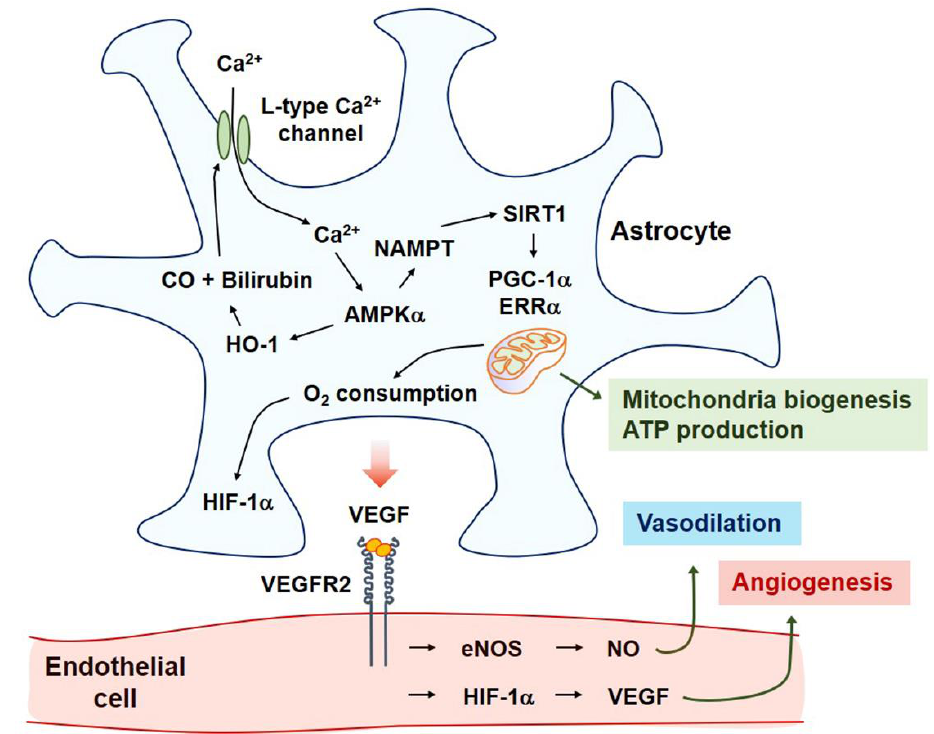
Figure 2. After the ischemia-reperfusion injury, HO-1 is expressed in the astrocytes of the penumbra of the ischemic brain. CO and bilirubin can be produced via enzymatic activity of HO-1, which then activates the L-type Ca 2+ channel, leading to the entry of extracellular Ca 2+ . Ca 2+ -mediated AMPK α - HO-1 circuit results in NAMPT gene expression and consequent SIRT1 activation. Deacetylation of PGC-1 α by SIRT1 activates ERR α expression. PGC-1 α -ERR α axis induces mitochondrial biogenesis, ATP production, and increased O 2 consumption. Reduction of O 2 inhibits PHD2 activity and then stabilizes HIF-1 α protein. Both the PGC-1 α -ERR α pathway and HIF-1 α pathway induce the expression and secretion of VEGF. VEGF dimerization and binding to VEGFR2 triggers the eNOS – NO axis and HIF-1 α– VEGF pathway in endothelial cells, leading to vasodilation and angiogenesis, respectively. Abbreviations: CO, carbon monoxide; HO-1, heme oxygenase-1; AMPK α , AMP-activated protein kinase α ; PGC-1 α , peroxisome proliferator- activated receptor γ -coactivator-1 α ; PHD, prolyl-4-hydroxylase domain; ERR α , estrogen-related receptor α ; SIRT1, sirtuin 1; NAMPT, nicotinamide phosphoribosyltransferase.